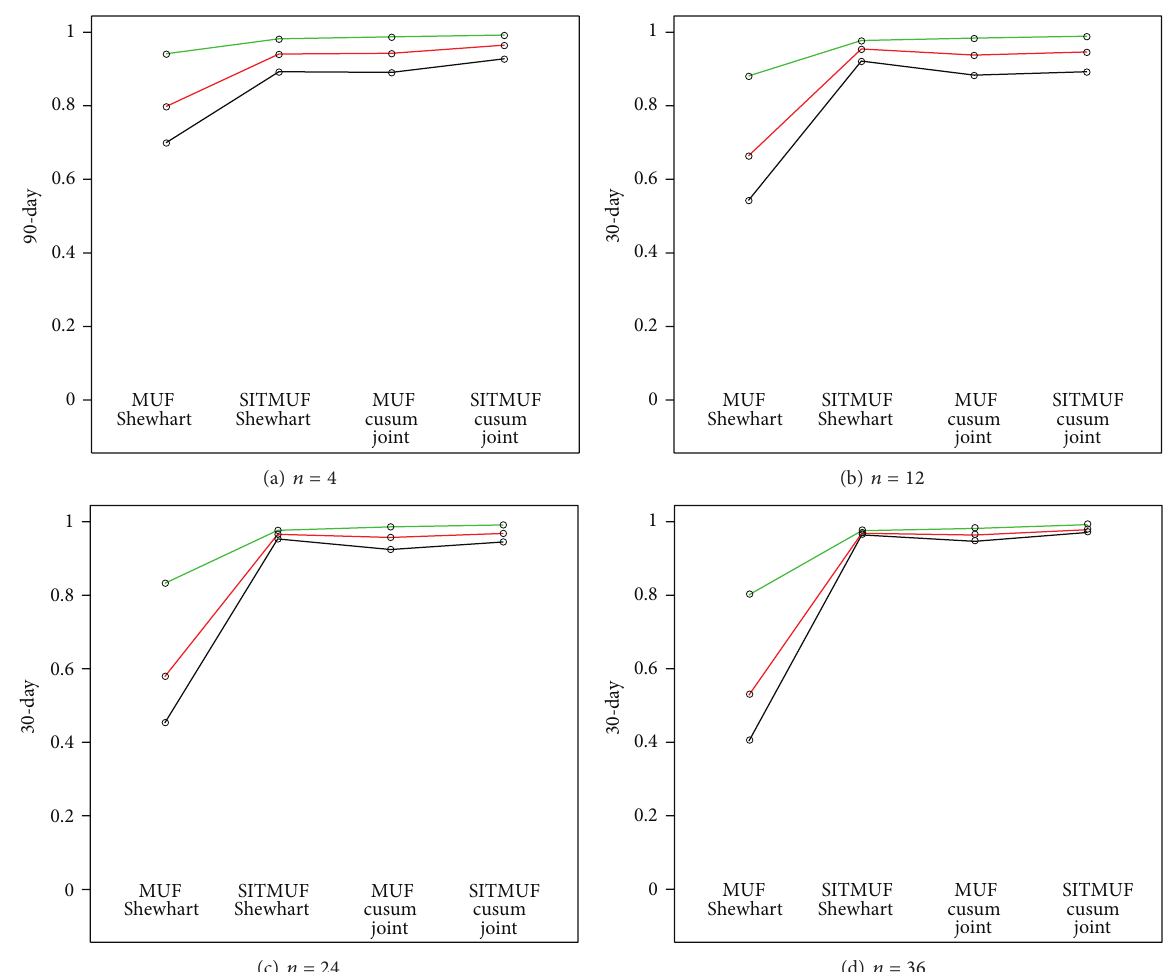
Figure 4: Timeliness AP for abrupt threat, 𝜎 𝑇 = 0.1 , 𝑀 = 4 . (Colors black, red, and green correspond to Σ 1 – Σ 3